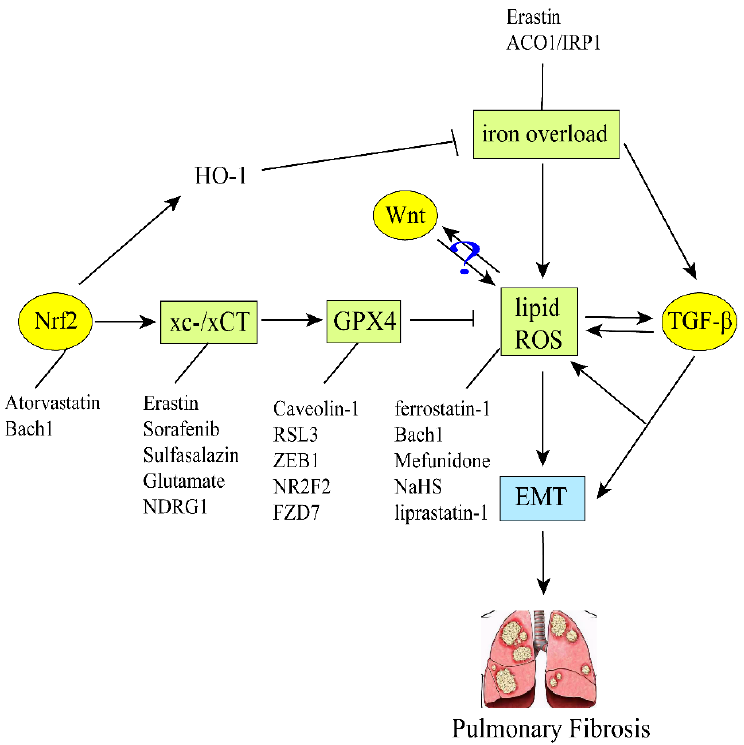
Figure 4. Ferroptosis regulates EMT-induced pulmonary fibrosis in the TGF- β/Smad, Nrf2 and Wnt signaling pathways. GPX4 and system xc- are ferroptosis markers. The decrease of GPX4 increases lipid and ROS. Various regulatory factors regulate system xc-, GPX4, ROS, respectively, and then induce EMT, finally leading to pulmonary fibrosis. Among them, the TGF- β and Nrf2 signaling pathways are associated with it to some extent, while the Wnt signaling pathway remains to be explored.